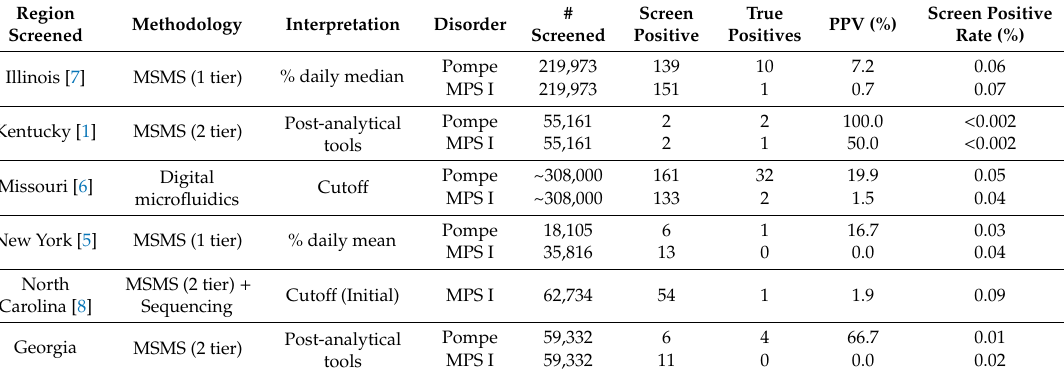
Table 1. Published results of US-based newborn screening (NBS) programs screening for Pompe disease (PD) and mucopolysaccharidosis type I (MPS I). Georgia data from this study are included in the last